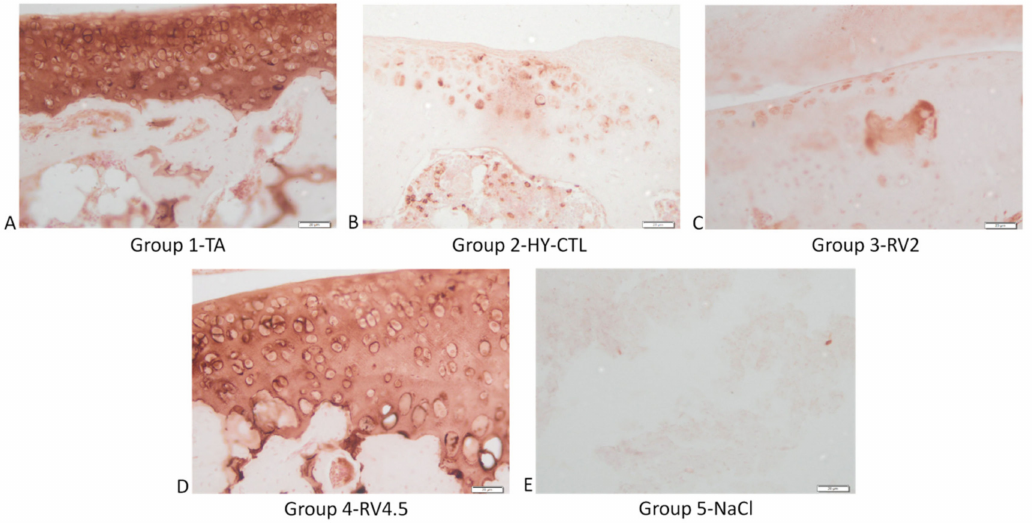
Figure 7. Immunohistochemical assessments of the right knee joints of rats. Images of the medial aspect of the joints treated with i.a injection of TA ( A ), HY-CTL ( B ), RV2 ( C ), RV4.5 ( D ) and NaCl ( E ). Type II collagen staining, magnification 40 × , bar = 20 µ m.